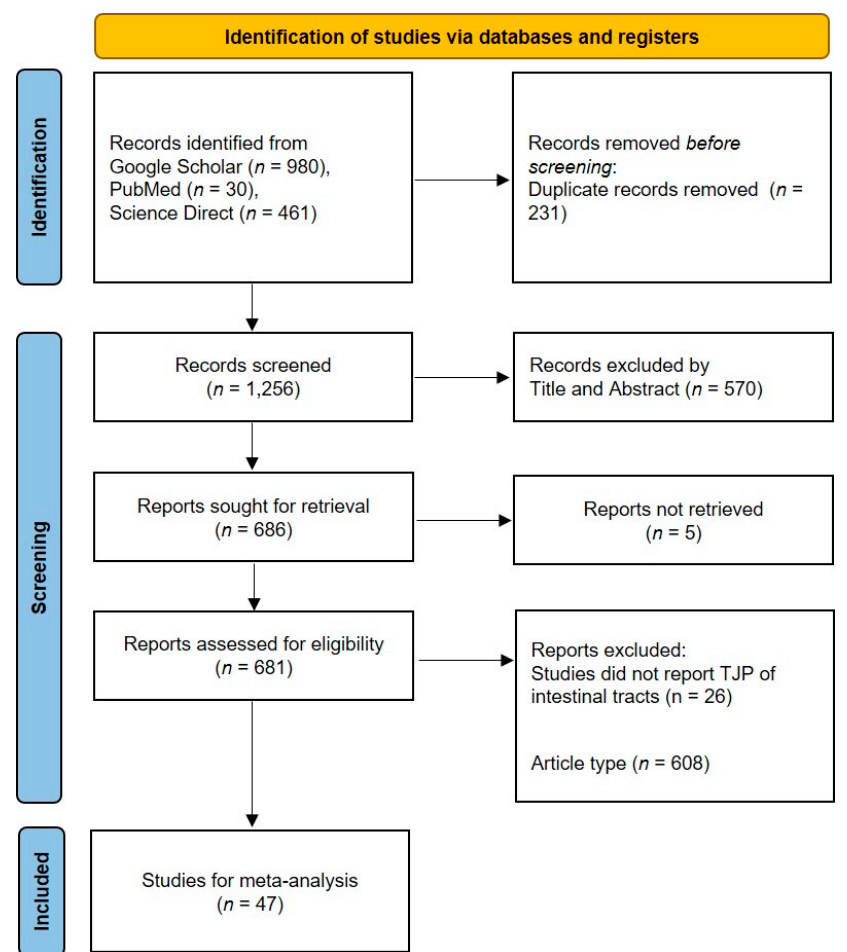
Figure 1. The PRISMA flow diagram of the procedure of data collection for the meta ‐ analysis. Table 1. Studies used in the data set and their information for the meta ‐ analysis.